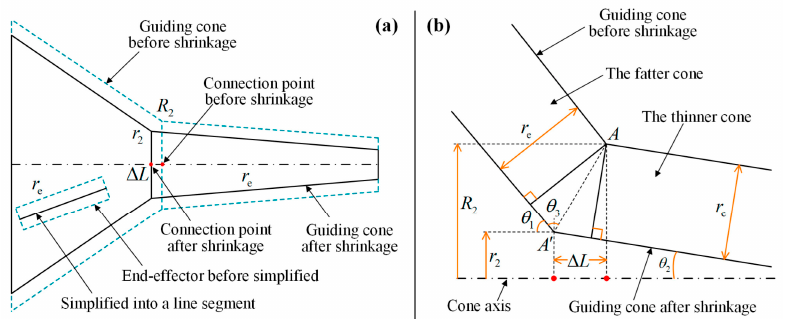
Figure 5. Radius compensation: ( a ) The shrinkage; ( b ) The geometric relationship.